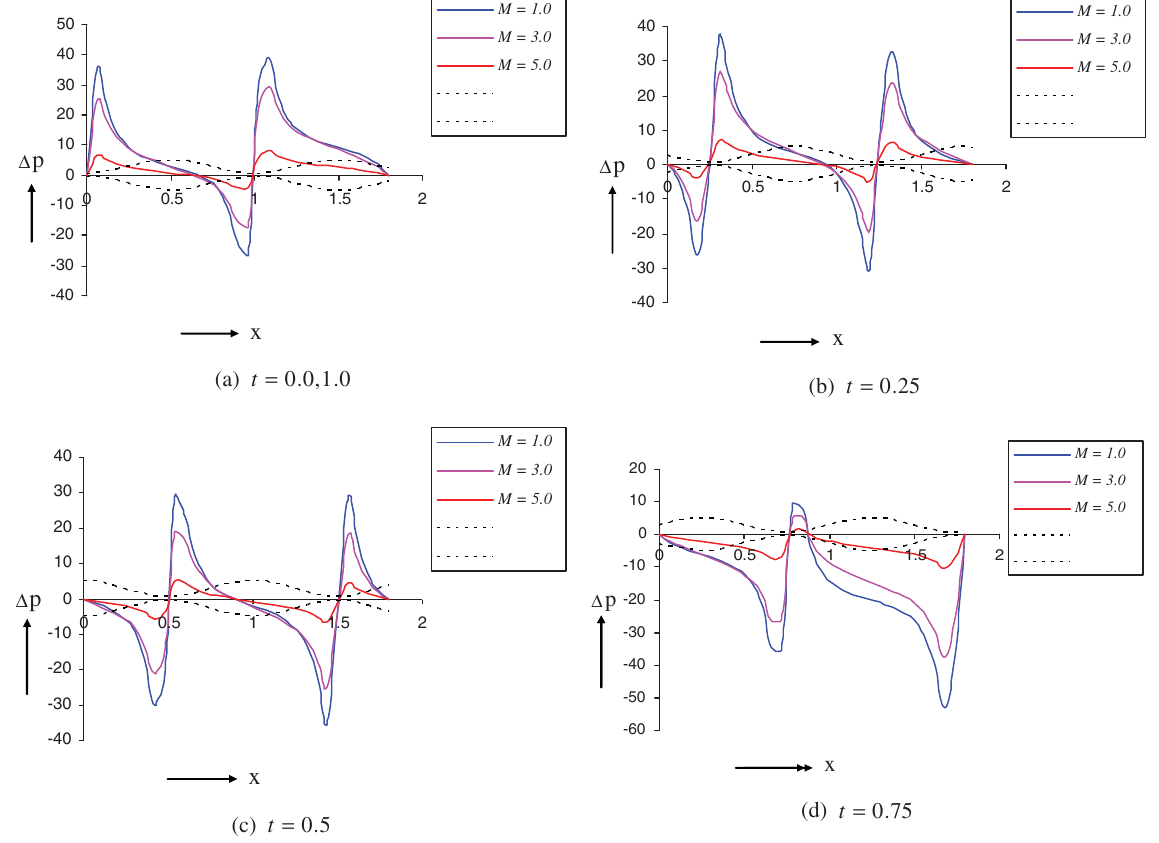
Fig.5. PressuredistributionalongtheaxialdistanceofthefinitelengthtubeatfivetimeinstantsbasedonEq.(23).Dottedlines( ······ )represent the position of wave, whereas continuous lines (—) represent the pressure distribution for M =1.0–5.0, φ =0.9, N =0.50 and l